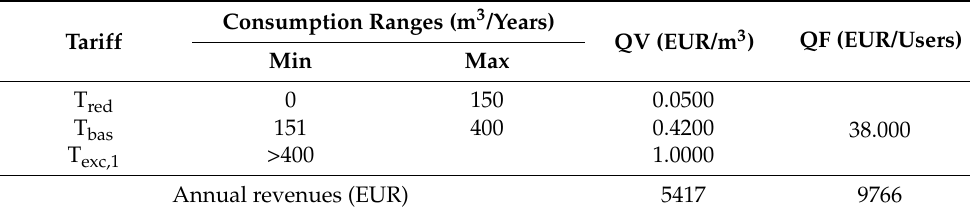
Table 1. Water tariffs and consumption ranges adopted by the operator before the introduction of